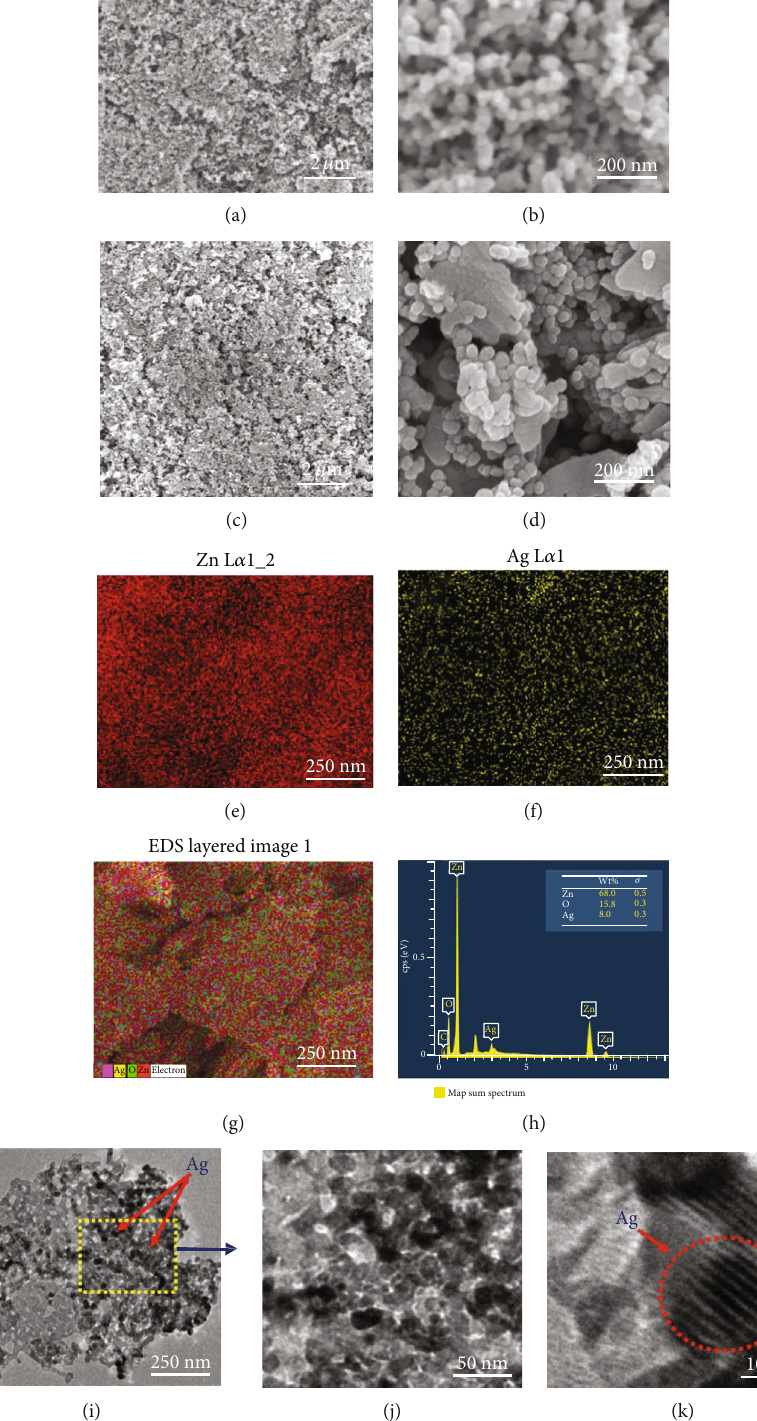
Figure 1: (a, b) SEM images of nano ZnO with the di ff erent scale bars; (c, d) SEM images with the di ff erent scale bars of the Ag/ZnO-10 nanocomposite; (e, f) element mapping images of Zn and Ag, respectively; (g, h) EDS layered image and EDS spectrum, respectively; (i, j) TEM images with the di ff erent scale bars; (k) HR-TEM image of the Ag/ZnO-10